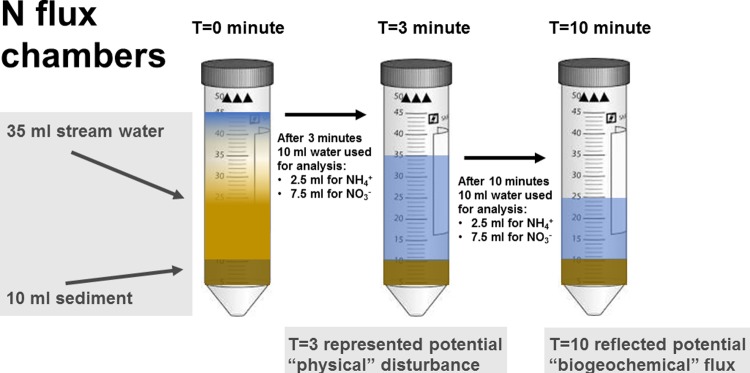
Experimental flux chambers: 10 mL sediment from the benthic zone were randomly collected, transferred into separate 50 mL falcon tubes and mixed with 35 mL stream water.For N samples, 10 mL water (2.5 mL for NH4+ and 7.5 mL for NO3- analysis) was extracted after the sediment had settled (T = 0 minutes), and after both 3 (T = 3 minutes) and 10 minutes (T = 10 minutes). The initial 0–3 minutes flux represented a “physical” disturbance event, while the 3–10 minutes flux reflected a “biogeochemical” flux.